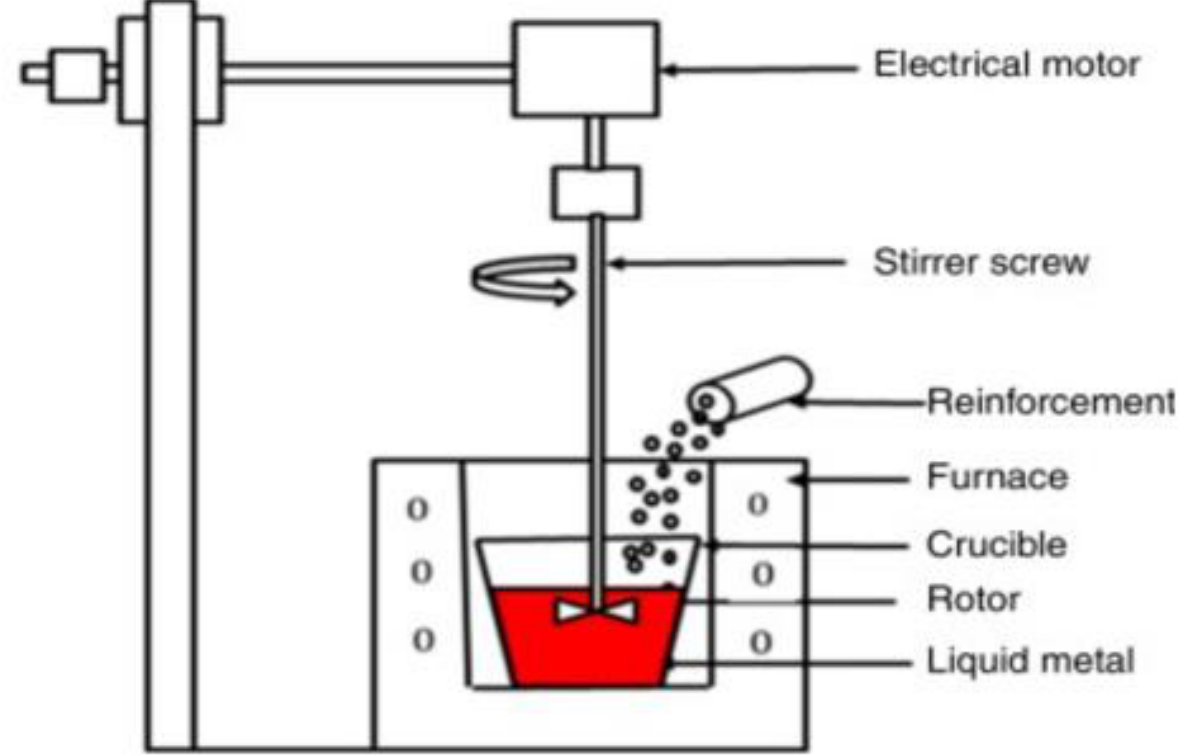
Figure 9. Stir casting system for AMMC manufacturing procedure.